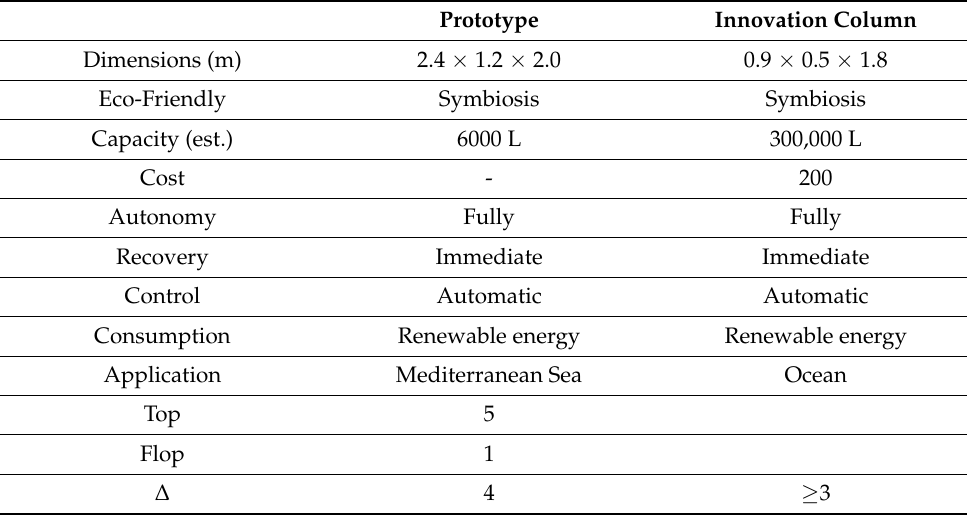
Table 8. Top–Flop Analysis of the New